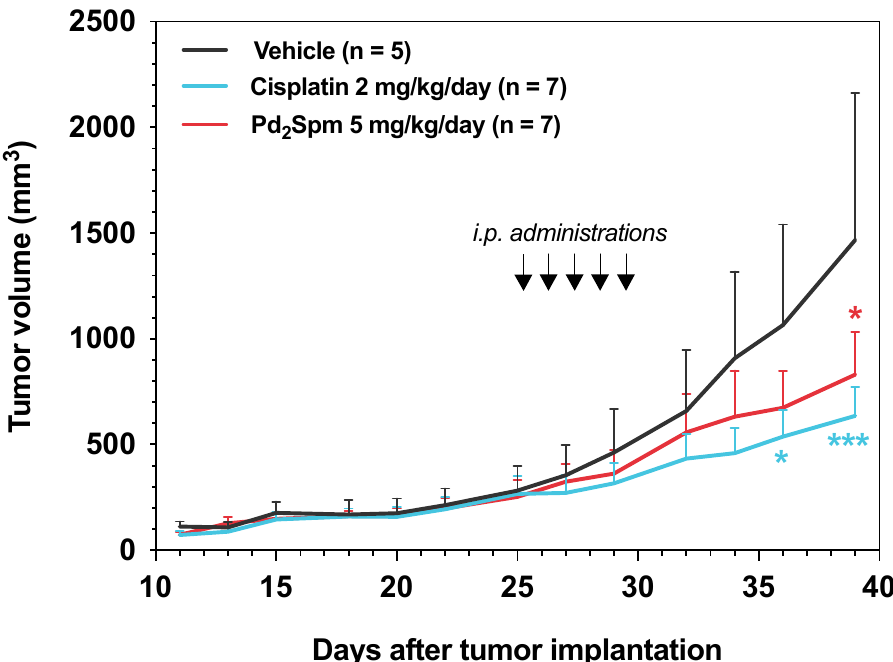
Figure 3. Pd 2 Spm suppresses tumor growth of MDA-MB-231 breast cancer xenografts. Graph of the effect of Pd 2 Spm treatment (5 mg/kg/day), cisplatin treatment (2 mg/kg/day) or vehicle (PBS + 0.5% DMSO) on MDA-MB-231 tumor volume. Drugs were administered intraperitoneally for 5 consecutive days in CBA nude female mice bearing subcutaneously implanted MDA-MB-231 triple-negative human breast cancer tumors. Data are expressed as mean tumor volume (mm 3 ) ± SEM and analyzed with two-way ANOVA followed by Tukey’s multiple comparison test. * p < 0.05 Pd 2 Spm versus vehicle; *** p < 0.001 cisplatin versus vehicle.